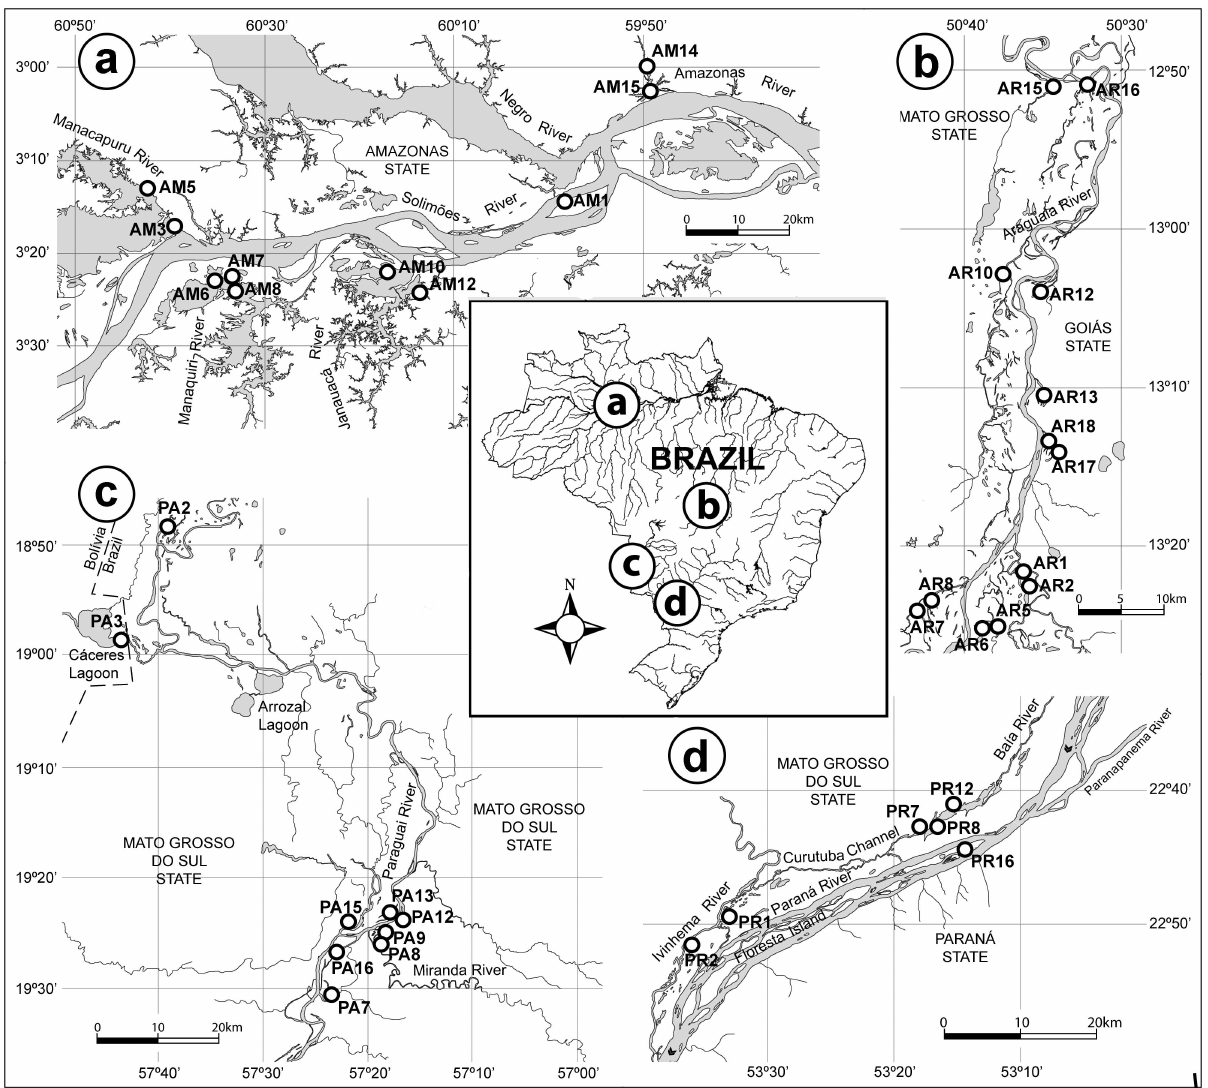
Fig 1. Map of the sampling locations in each basin study system. (i.e. a = Amazon floodplain; b = Araguaiafloodplain; c = Pantanal floodplain; d = Parana´ floodplain).Each point in the map represents a lake where carbon sources were sampledand limnological parameters were quantified. AM = Amazon; AR = Araguaia;PA = Pantanal; PR = Parana´. This figure is similar but not identicalto the originalimage (i.e. in Arrieira et al. [56]), and is therefore for illustrative